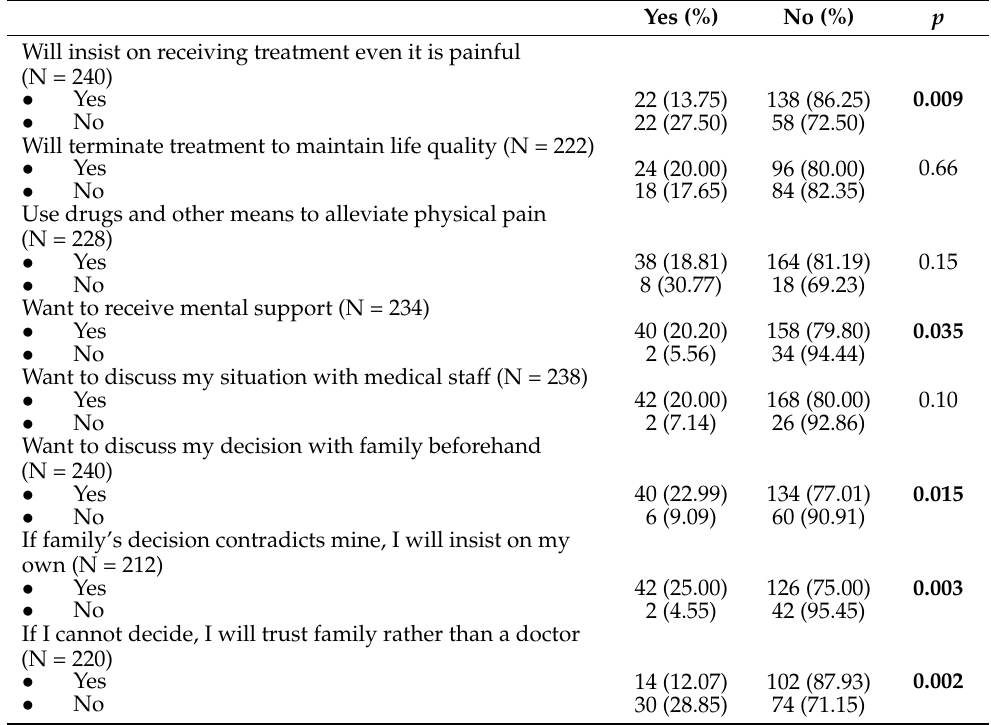
Table 3. Participants’ medical treatment and decision making according to advance care